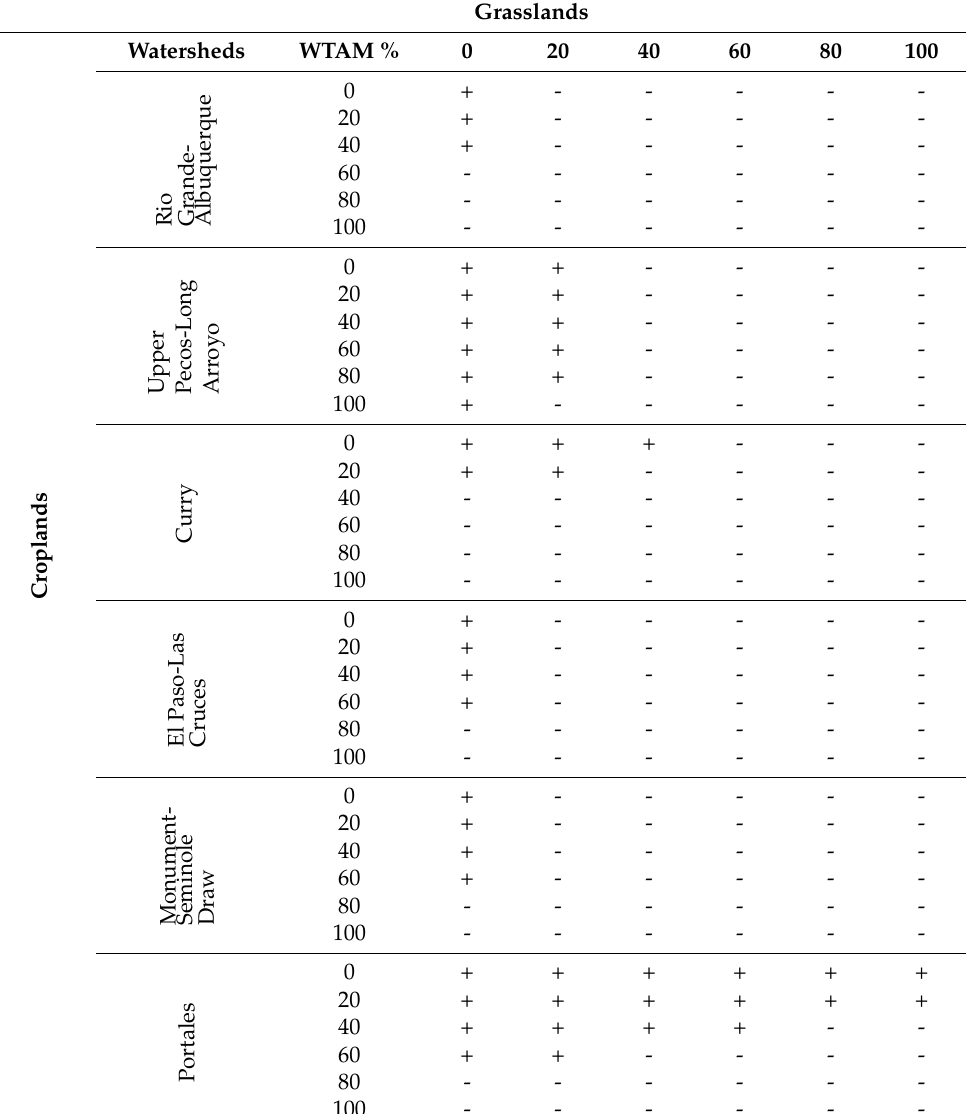
Table 4. Watershed-level nitrogen balance under alternative WTAM of croplands and grasslands.